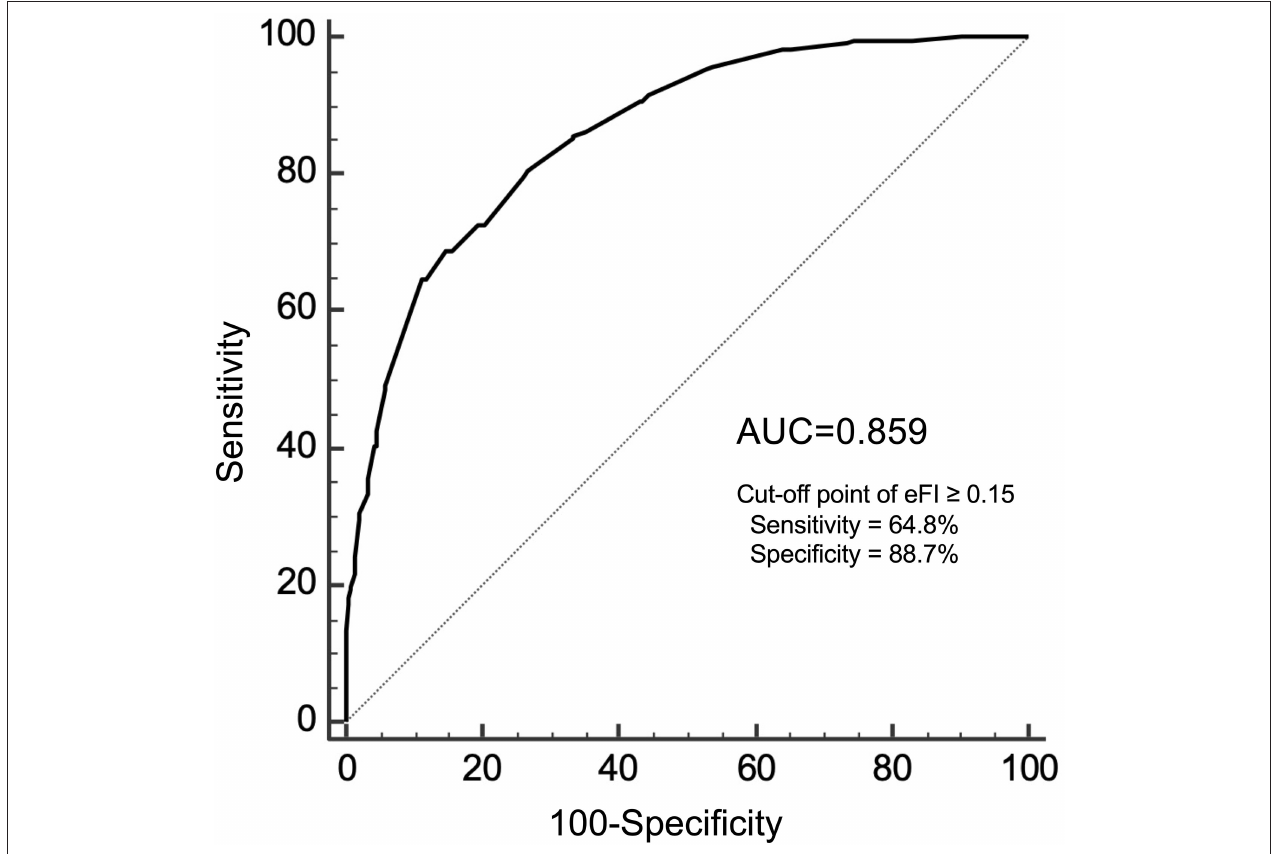
FIGURE 4 | The ROC analysis for the eFI against CGA-FI ≥ 0.25 to identify frailty. ROC, receiver operating characteristic; eFI, electronic frailty index; CGA-FI, comprehensive geriatric assessment-frailty index; AUC, area under the